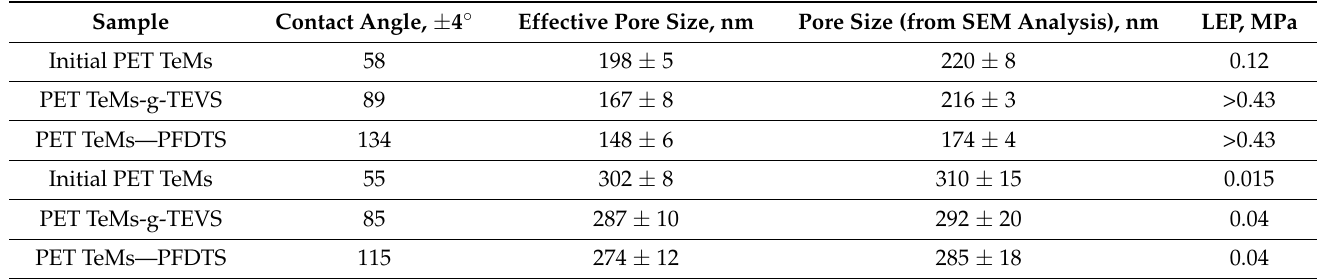
Table 2. Properties of PET TeMs before and after